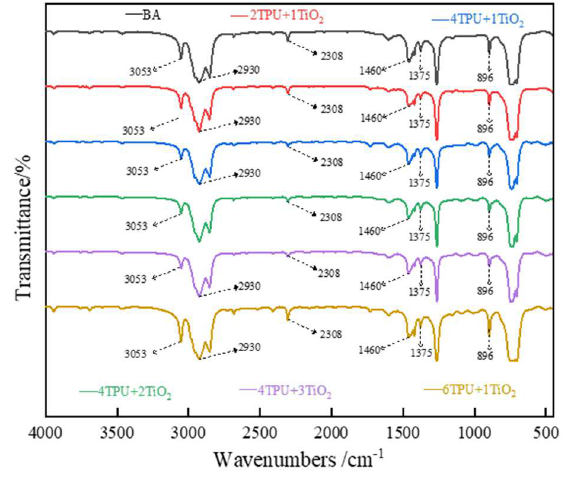
Figure 9. FTIR diagram of asphalt binder.